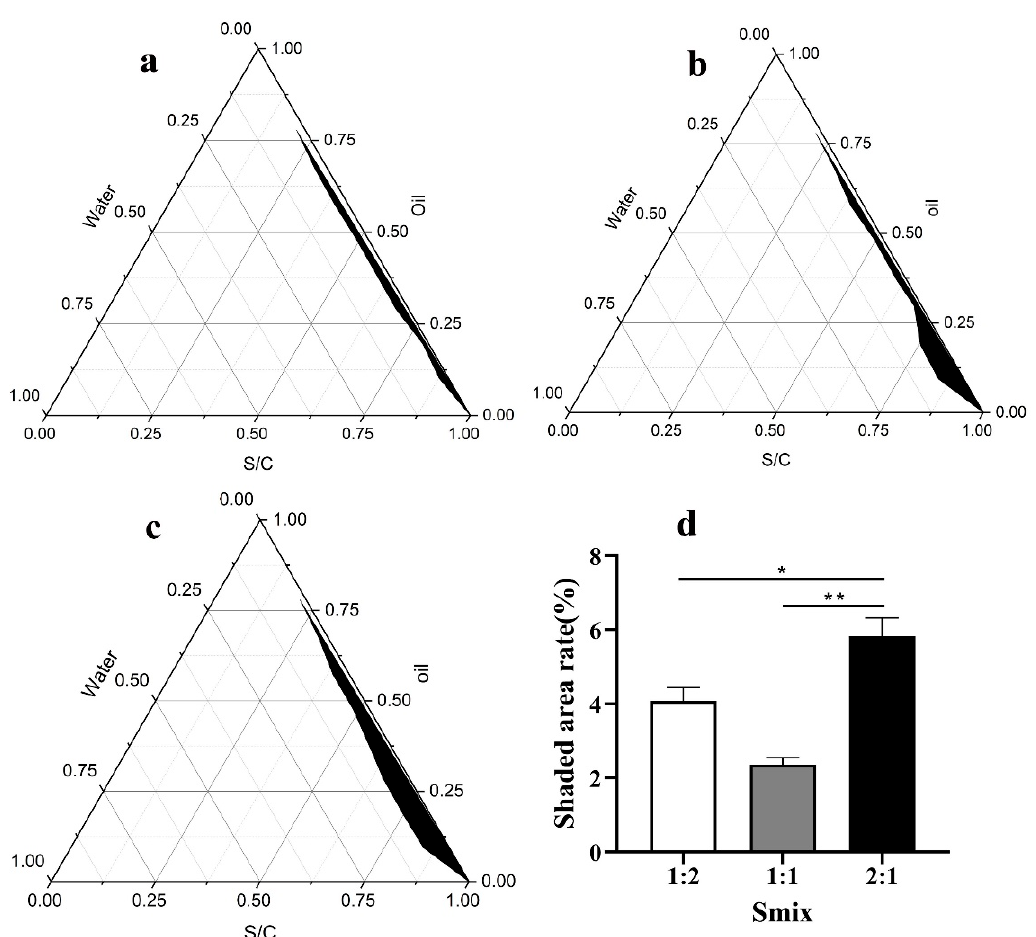
Smix = 1:1 (Figure 1a) and Smix = 1:2 (Figure 1b). Based on the largest black area in the phase diagram (Figure 1d), Smix = 2:1 was accepted and applied for the preparation of nano-emulsions.